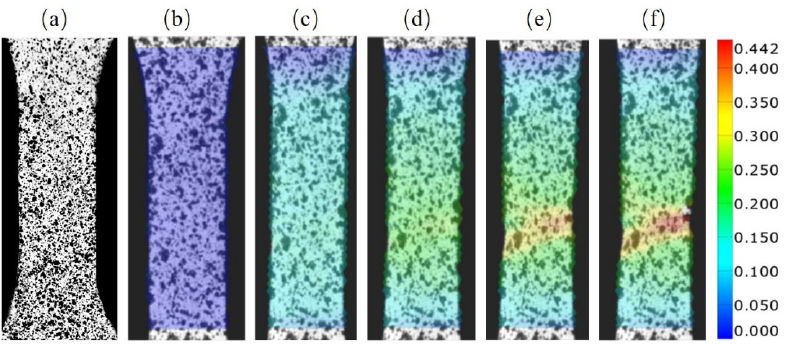
Figure 5. A typical equivalent strain profile of foils at different stages. ( a ) Original state, ( b , c ) homogeneous deformation stage, ( d ) transition of deformation stage, ( e , f ) concentrated deformation stage.